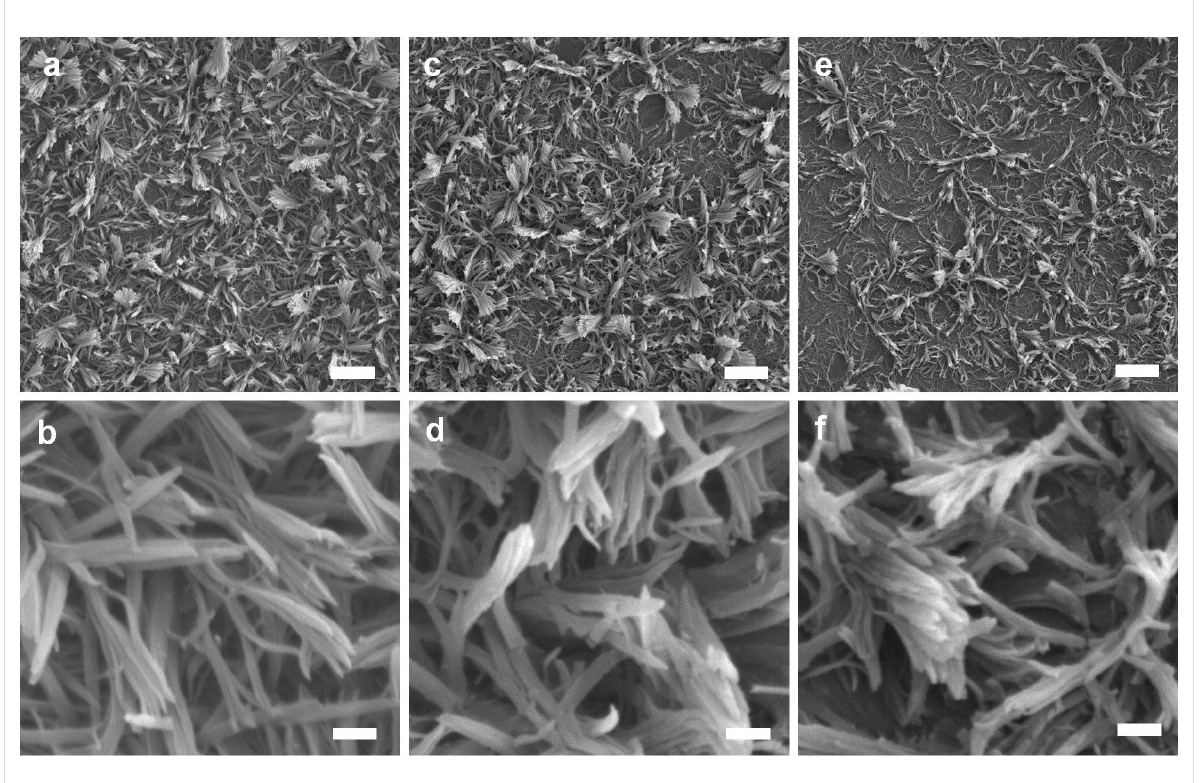
Figure 9: SEM images of nanograss surfaces of LPEI@silica (a and b), LPEI@silica @titania (c and d) and silica@titania (e and f). The scale bars are 5 μ m (a, c and e) and 500 nm (b, d and f).